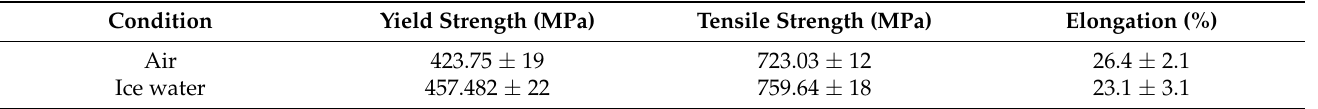
Table 3. Tensile data of the yield strength, tensile strength, and